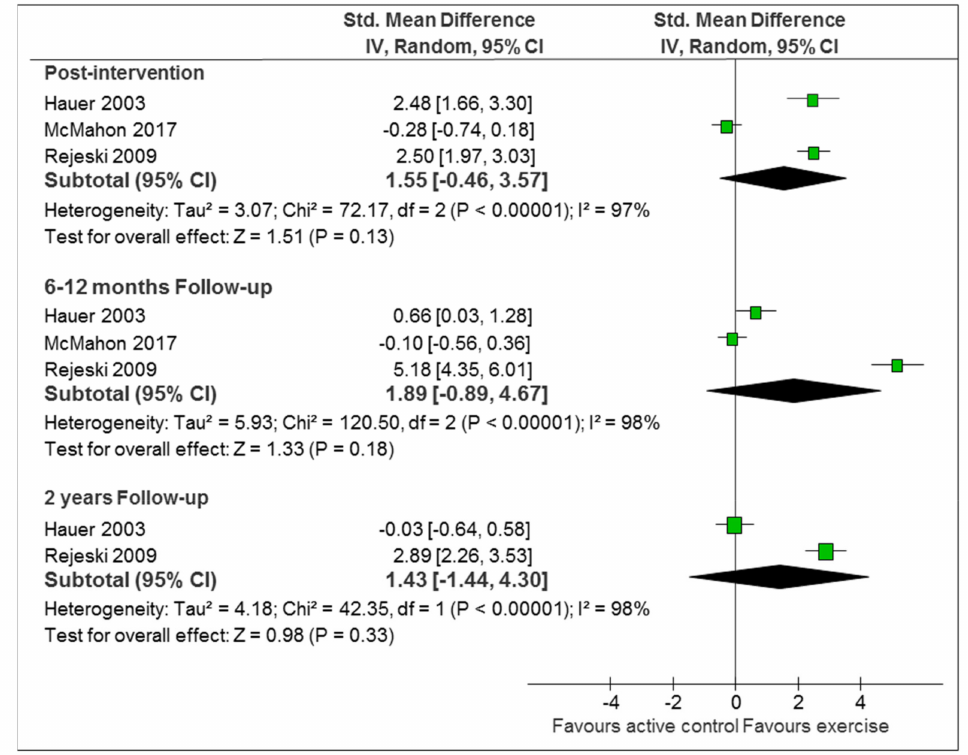
Figure 2. Exercise-based intervention versus active control (self-reported PA: physical